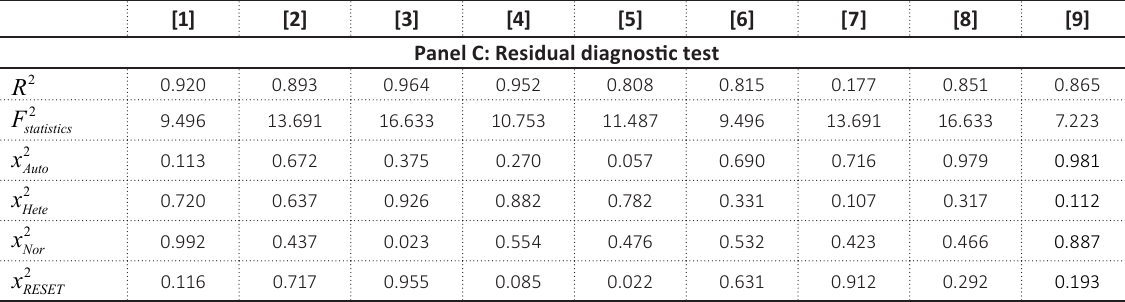
Table 6 (cont.). Long-run and short-run model coefficients